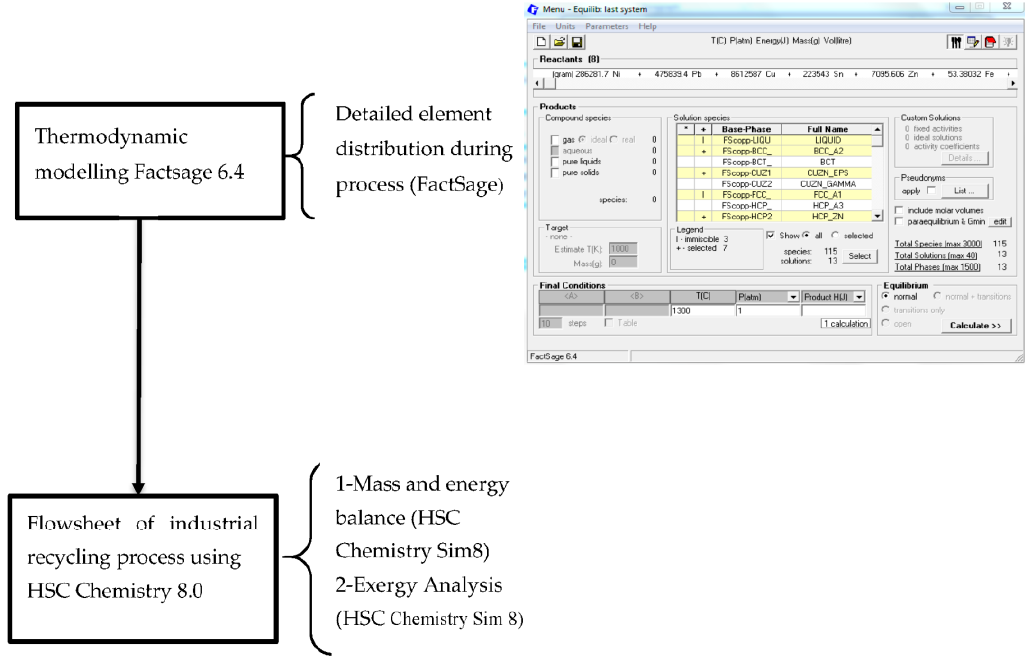
Figure 3. Flow chart of the procedure performing the exergy analysis.